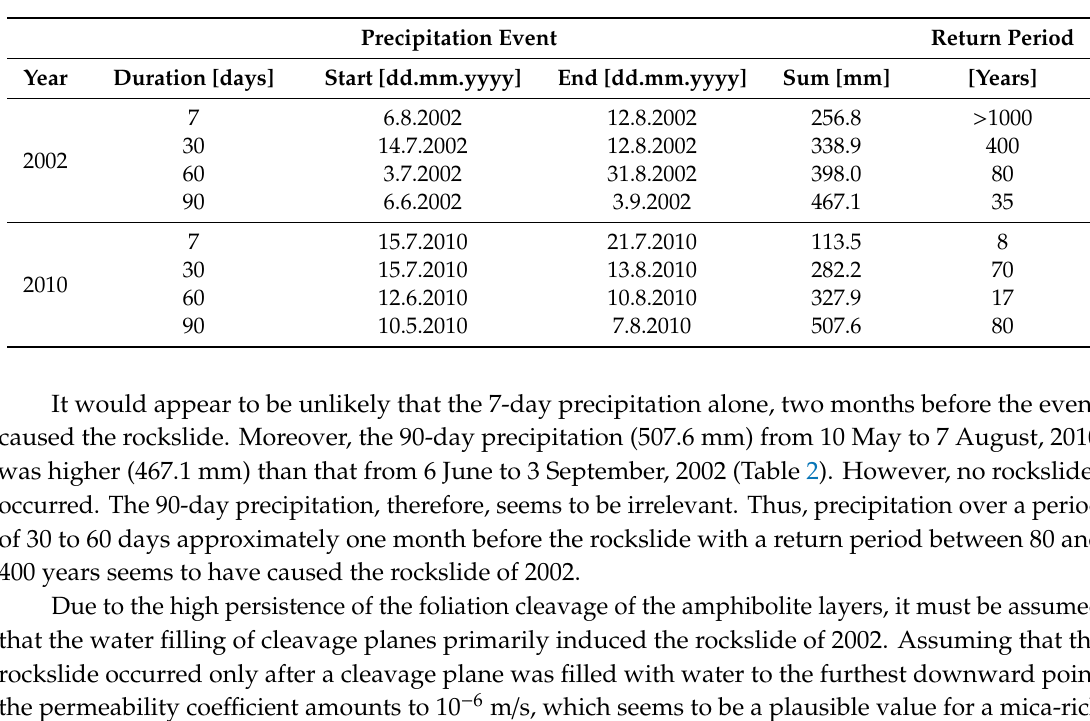
Figure 6. The annual sum of precipitation recorded by Muehldorf bei Spitz weather station and rockslides in the Spitz quarry between 1960 and 2015 (length of arrows proportional to rockslide volume). Table 2. Extreme precipitation